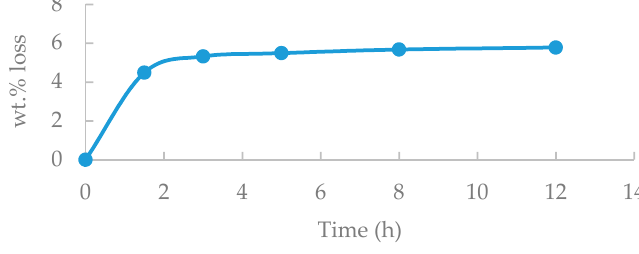
Figure 9. Weight loss changes with time for the solvent debinding.